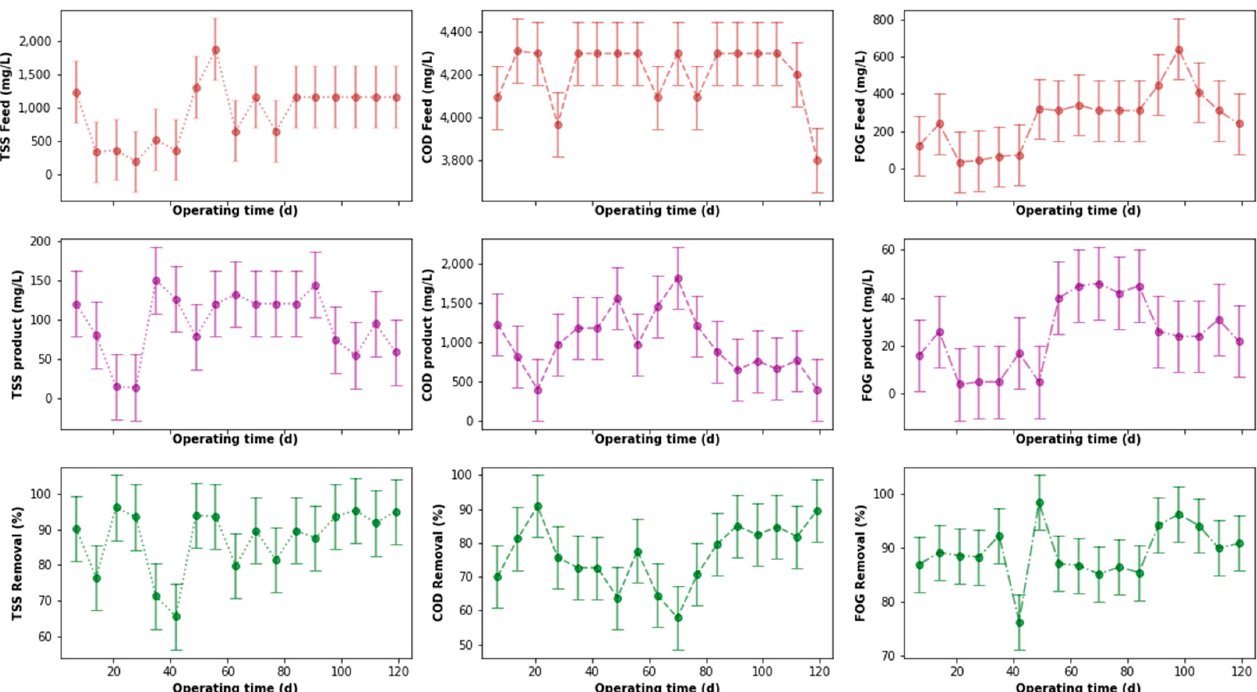
Figure 13. Performance of the pre ‐ treatment stage coupled with the EGSB. Initially, low ‐ percentage reductions were noted for TSS in the pre ‐ treatment tank at an average of 48% which was not a significant reduction; however, it could be noted that